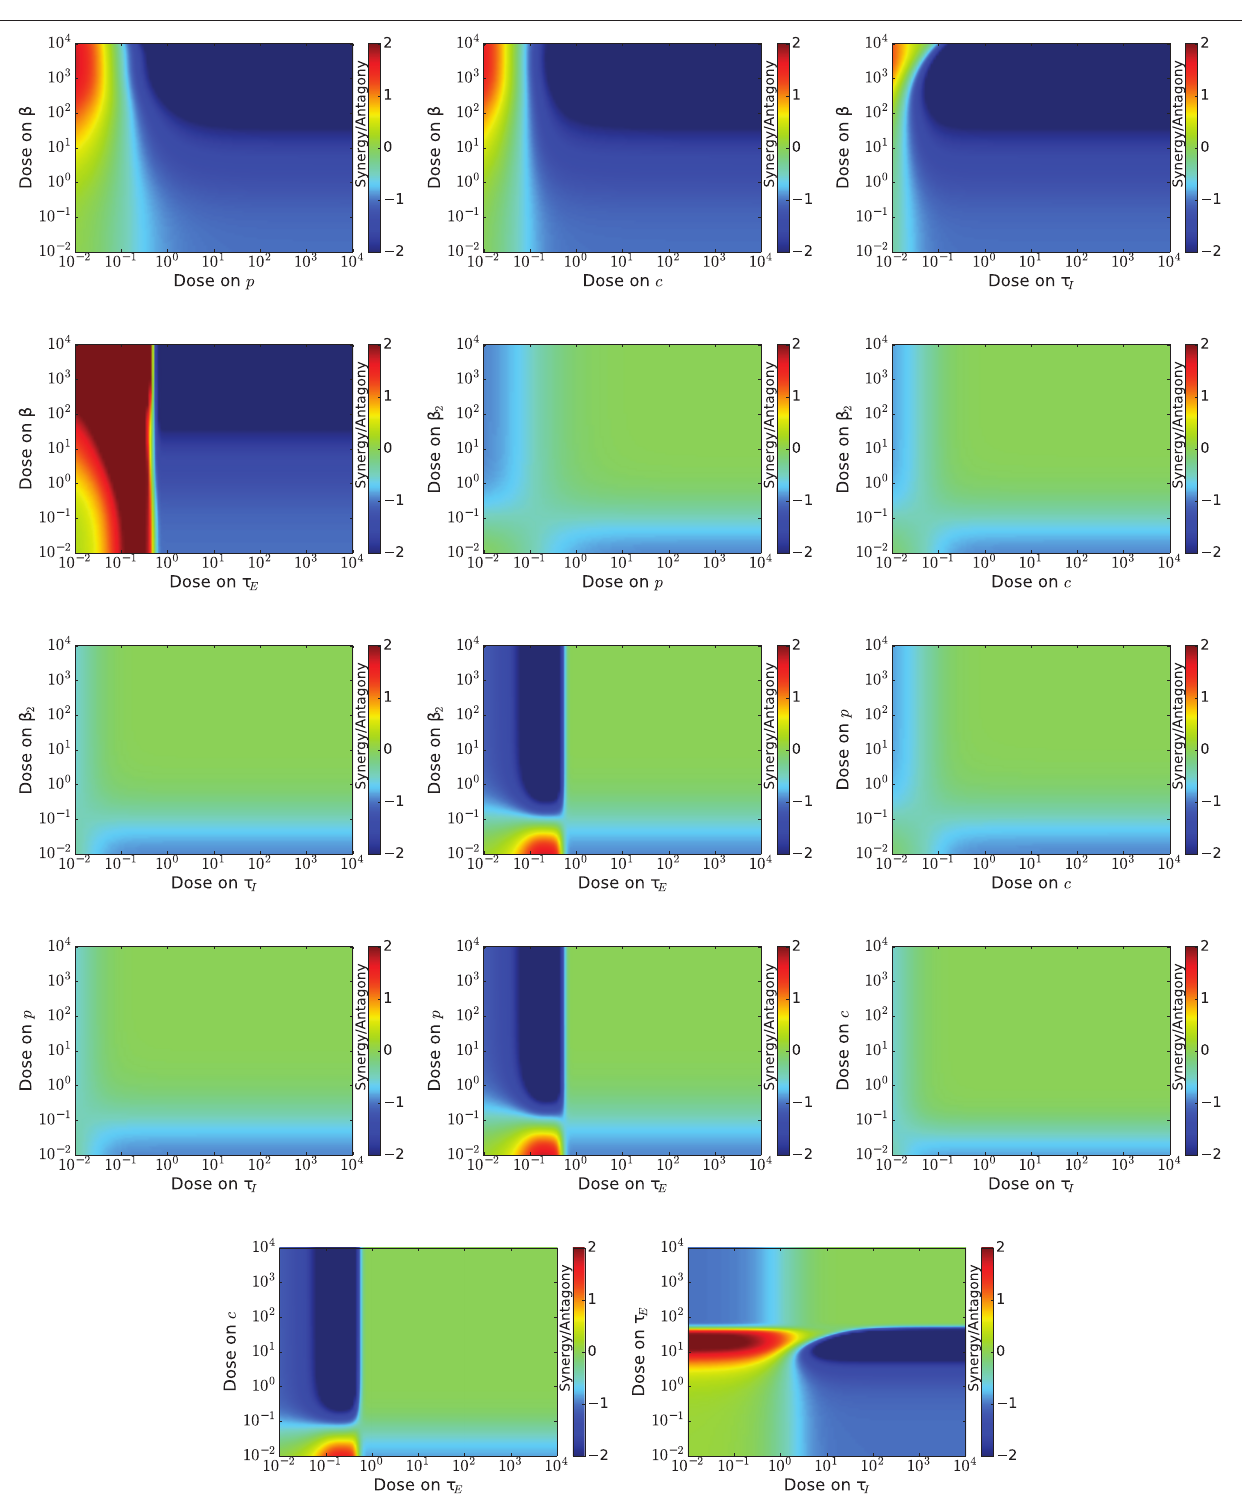
Frontiers in Pharmacology | www.frontiersin.org